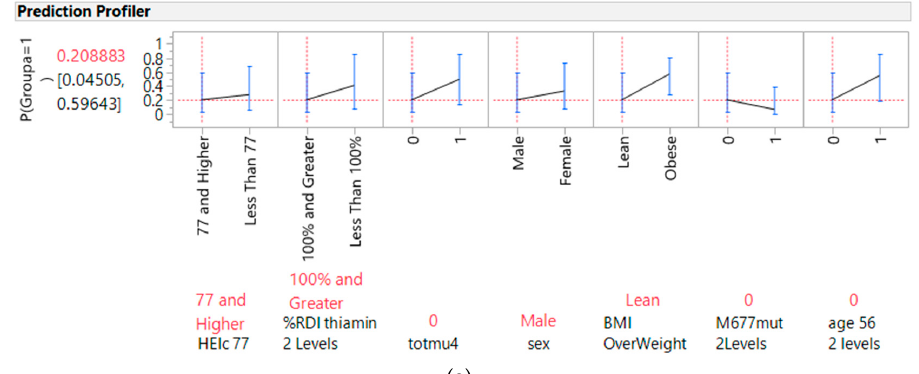
Figure 1. Genes involved in the prediction of colorectal cancer: ( a ) per single gene profiler, total polymorphism score and total methylenetetrahydrofolate reductase (MTHFR) enzyme deficiency (calculated based on MTHFR 677 and 1298 (presented as M677mut 2Levels and MA1298C 2) polymorphism mutation alleles), ( b ) interaction profilers of selected gene parameters and colorectal cancer. Note that the MTHFR 677 polymorphism status (0 or 1) overlapped with no discrimination against other genetic factors in regard to its association with cancer risk; p (Groupa) = 1 is the probability of predicting a level 1 (cancer status versus 0, the control status) response, MTA2756G 2: methionine synthase A2756G in 2 levels, MTRRA66G 2: methionine synthase reductase A66G in 2 levels, DHFR19bp del: dihydrofolate reductase 19 base pair deletion, MTHFRd50: MTHFR enzyme deficient 50% or higher.